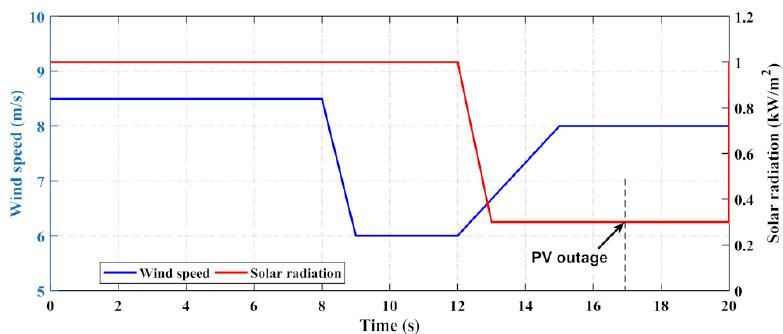
Figure 9. Wind speed and solar irradiation profiles.